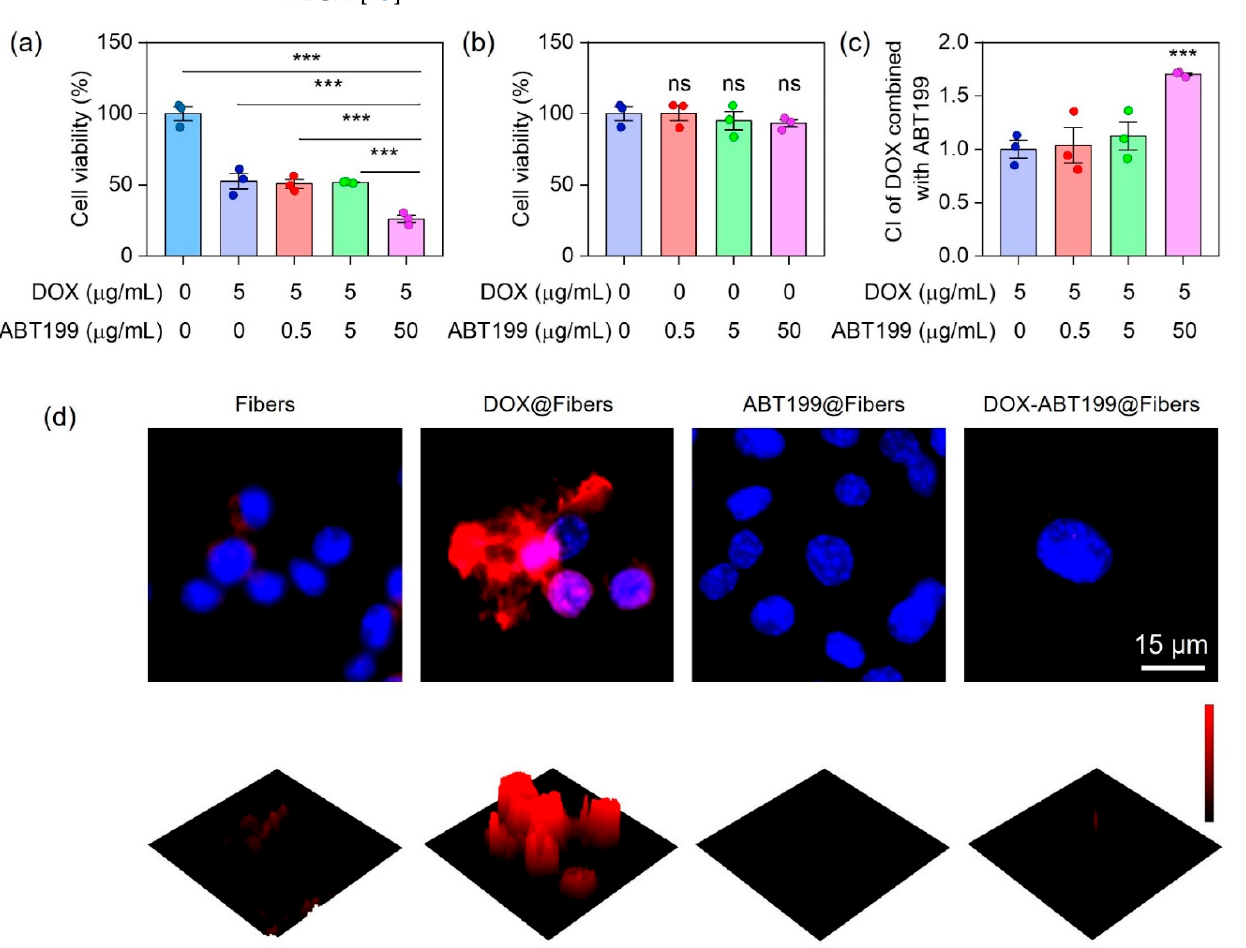
Figure 4. Synergistic tumor cell inhibition effect of DOX combined with ABT199 in vitro. ( a , b ) The cell viabilities of RM-1 cells, and ( c ) the CI of DOX combined with ABT199, calculated based on the cell viability. ( d ) The immunofluorescence images of RM-1 cells showing the Bcl-2 expression after receiving different treatments (*** stands for p < 0.001 and ns stands for no statistical significance).